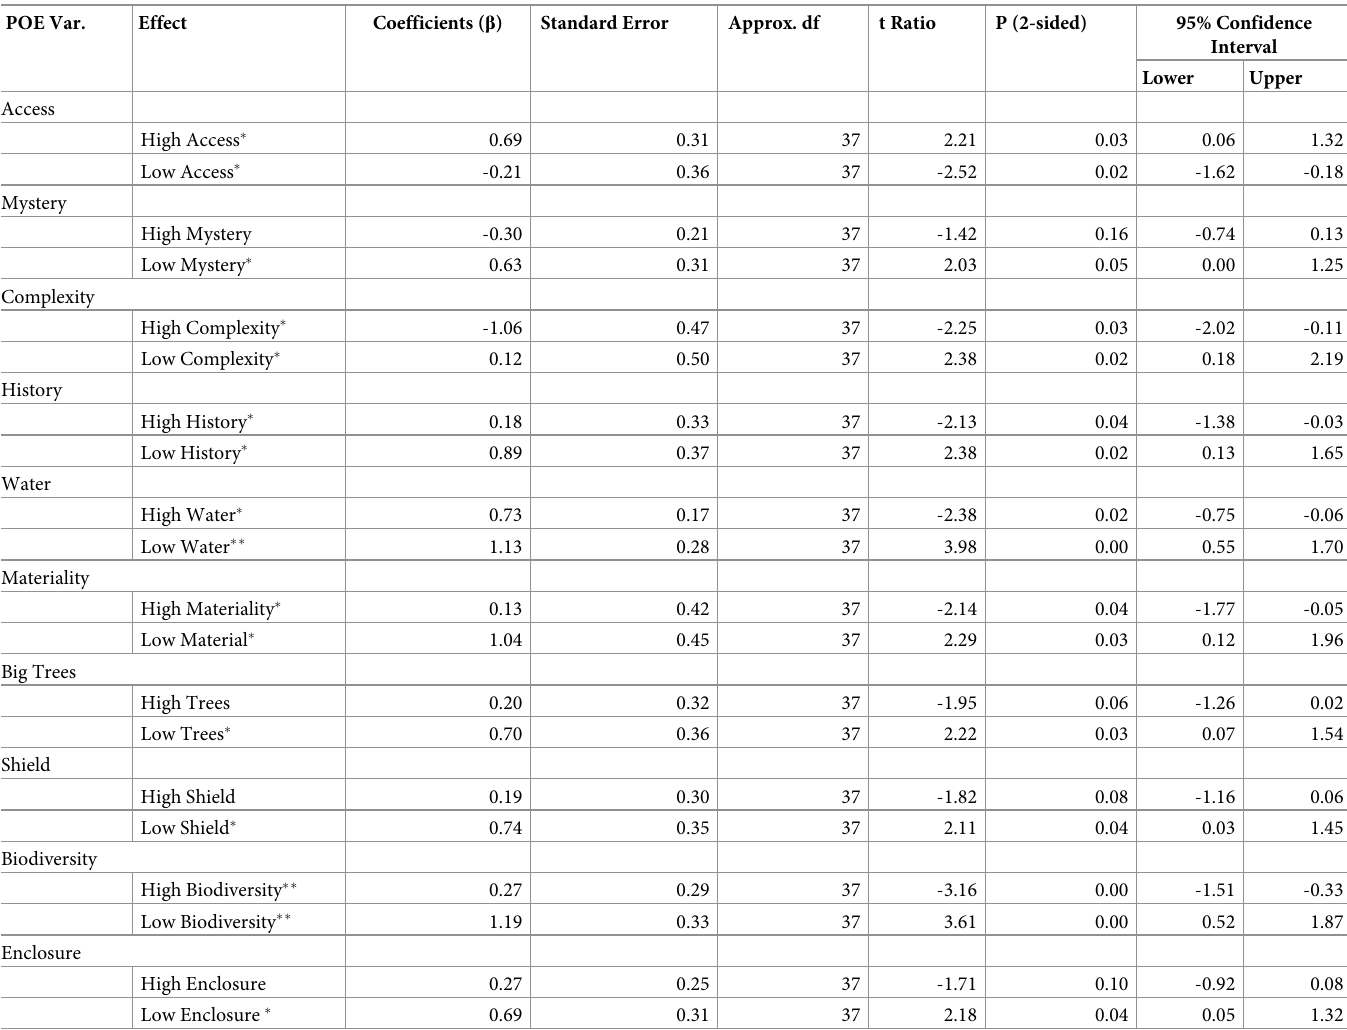
Table 4. Fixed effects from 62 item POE across 44 transect